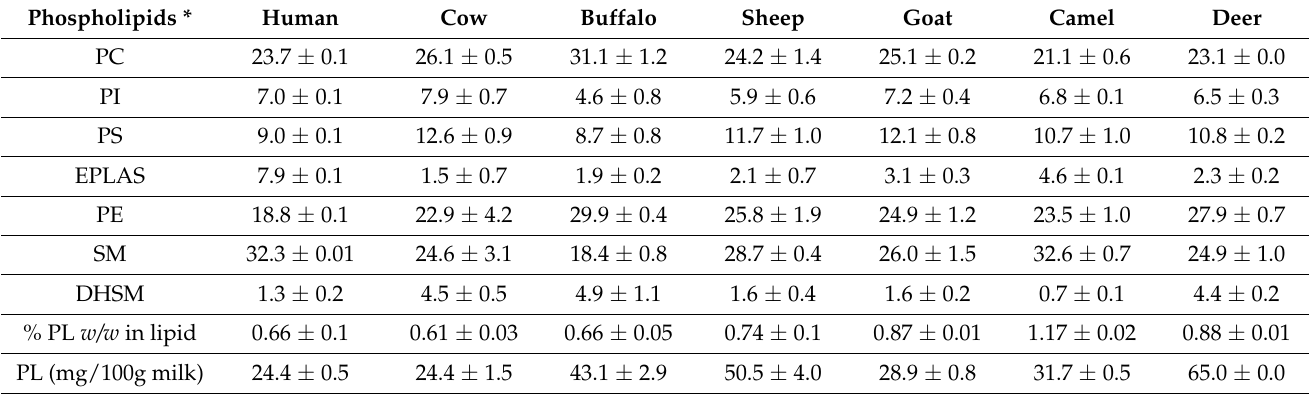
Table 2. Phospholipids in the samples studied (presented as averages ± standard deviations in weight % of total phospholipids, unless otherwise indicated). Samples were analysed in triplicate; human milk data is averaged from the data from the three different donors’ milks.